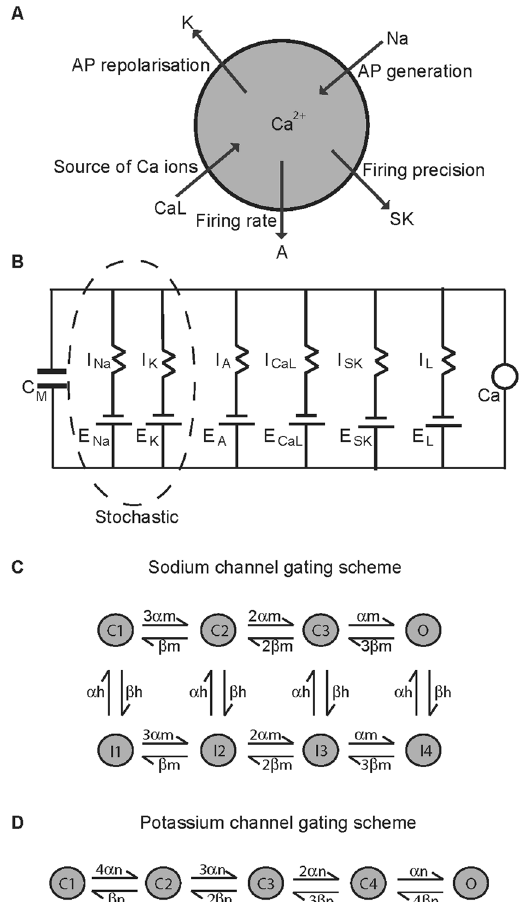
Figure 1. Dopamine neuron model. ( A ) A single spherical compartment of diameter 10 μ m and capacitance 1 μ F represents the dopamine neuron soma. It is incorporated with those ionic conductances known to be sufficient to reproduce the basic electrophysiological features associated with these neurons, such as the Na (sodium channel) and K (delayed rectifier potassium channel) that regulate the generation and repolarisation of the action potential respectively; the A (A-type potassium channel) that helps maintain firing frequency; CaL (L-type calcium channel) that provides the bulk of intracellular calcium; SK (calcium-activated potassium channel of the SK type) that maintains firing regularity. ( B ) The Hodgkin-Huxley style equivalent electrical circuit for the model schematic in ( A ). The sodium and delayed rectifier potassium channels are modelled as stochastic, keeping all other ion channels deterministic. The neuronal membrane is considered as a capacitor with capacitance C M and with ion channels in parallel to each other. E ion is the electromotive force that represents the reversal potential of the respective ion channel, I ion represents the current flowing through them, and Ca is the intracellular calcium ion concentration. ( C , D ) Markov gating schemes for sodium and potassium channels respectively. Each sodium channel can exist in one of activated/open, inactivated or closed states while each potassium channel can either be open or